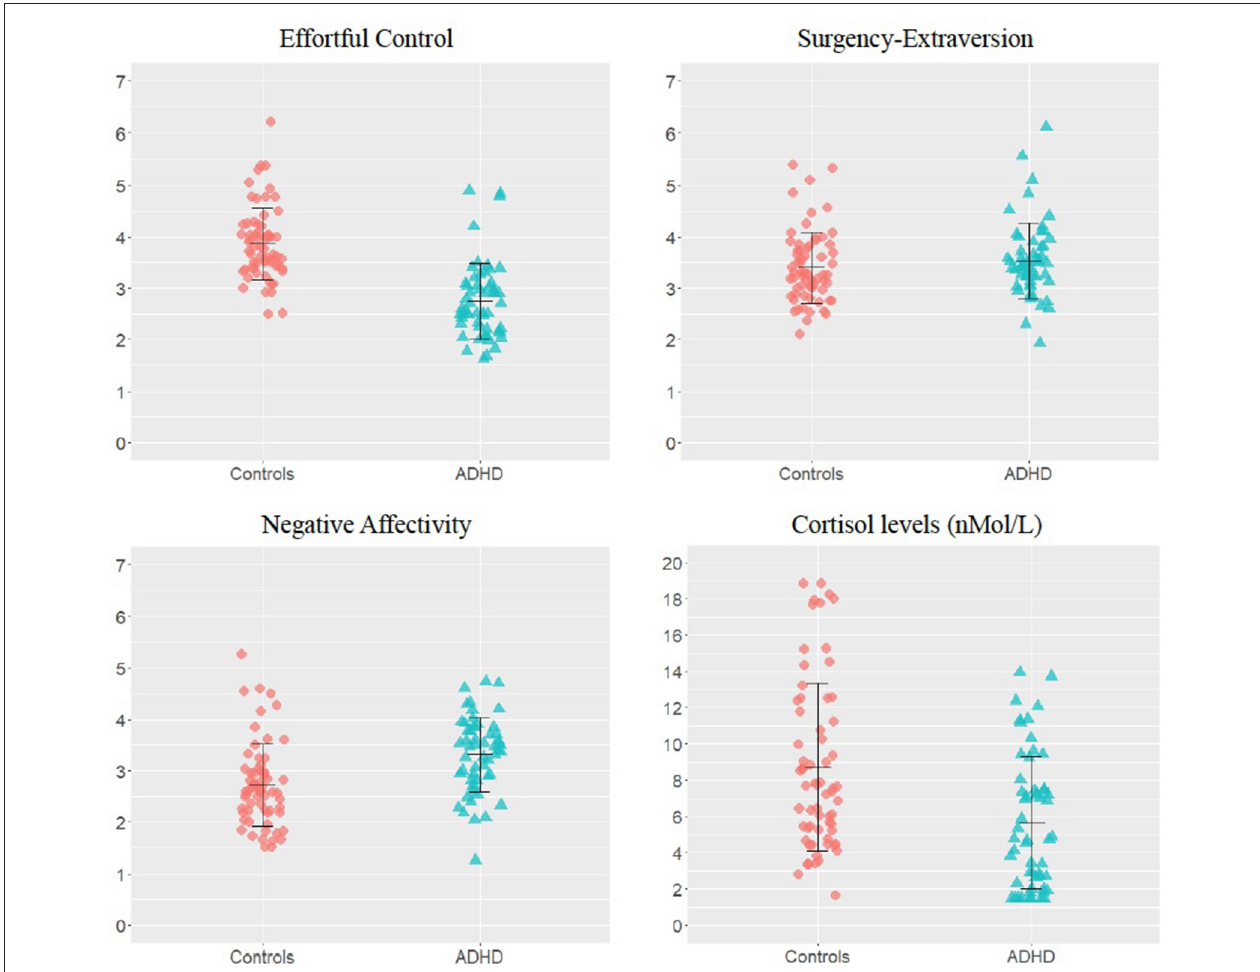
FIGURE 1 | Group differences on temperament dimensions and awakening cortisol levels. Unstandardized scores on the temperament dimensions subscales and awakening cortisol levels in the attention-deficit/hyperactivity disorder (ADHD) and control groups. The error bars represent standard deviations.